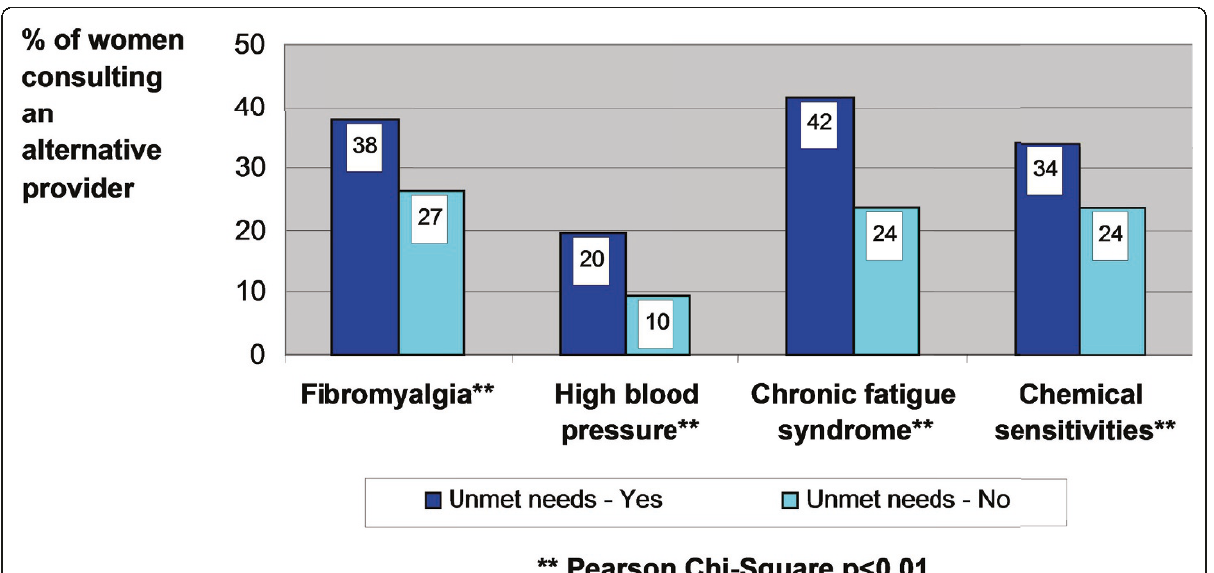
Figure 3 Percentage of women reporting unmet health care needs consulting an alternative health care provider, by chronic condition